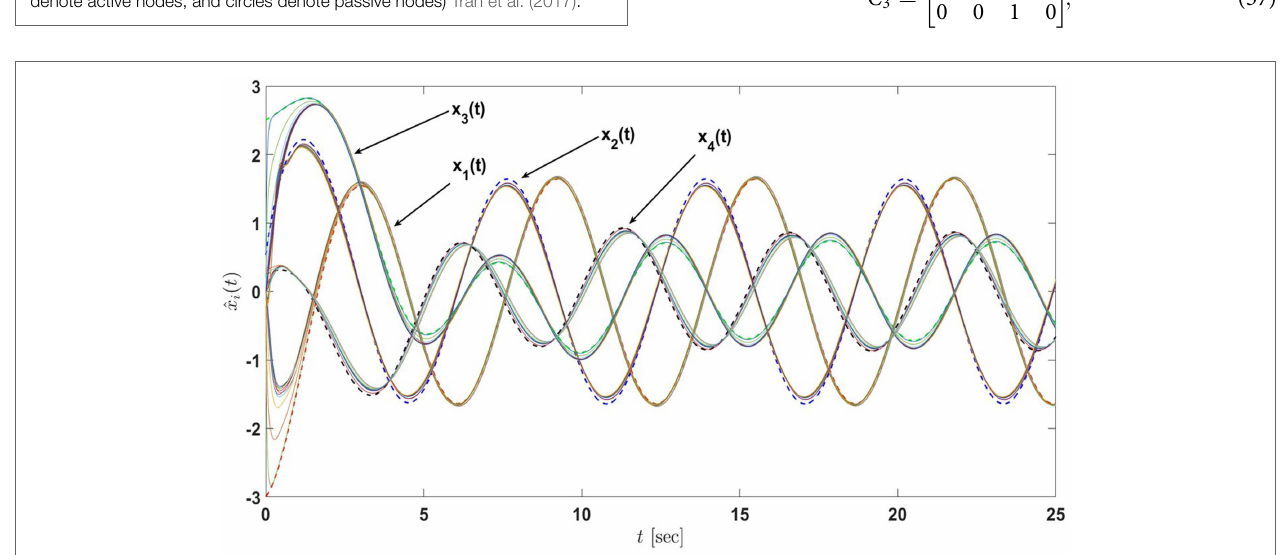
FIGURE 3 | State estimates of the sensor network in Example 1 with 4 active nodes and 8 passive nodes under the proposed architecture equations (7) and (8) (the dash lines denote the states of the actual process and the solid lines denote the state estimates of nodes) Tran et al. (2017).